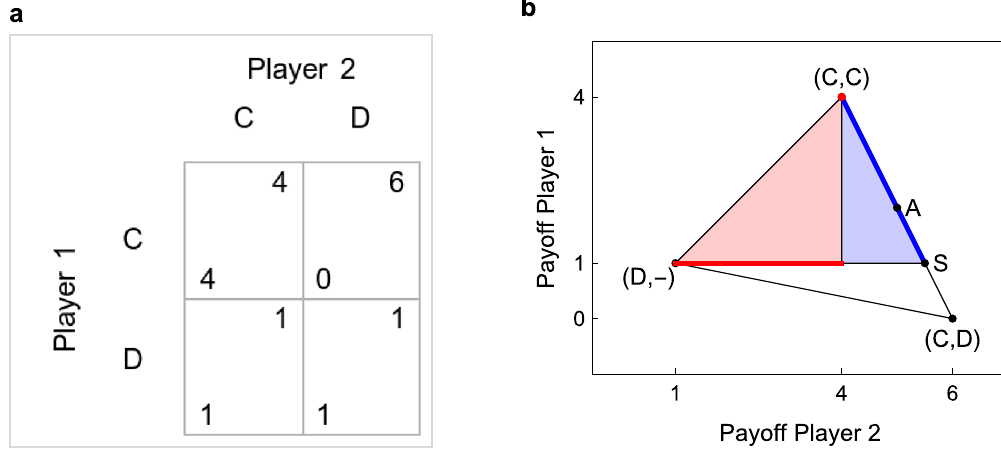
Figure 1. The STG we used for our experiment ( a ), and the set of feasible payoff profiles ( b ). If the game is played repeatedly and the players are sufficiently patient, every point in the colored areas can be sustained in a (subgame perfect) NE. Points in the blue area correspond to extortionate equilibria; that is, equilibria in which Player 2 obtains more than the mutual cooperation payoff. If Player 1 is constrained to memory-one strategies, extortionate equilibria exist only if she can observe the mixed strategy chosen by Player 2. If Player 1 only observes the outcome of the previous round, the only payoff profiles that can be sustained in equilibrium